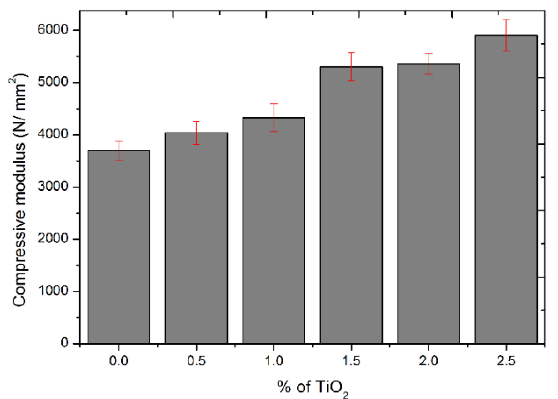
Fig. 8. Compressive modulus of Epoxy-TiO 2 nanocomposites at different concentrations